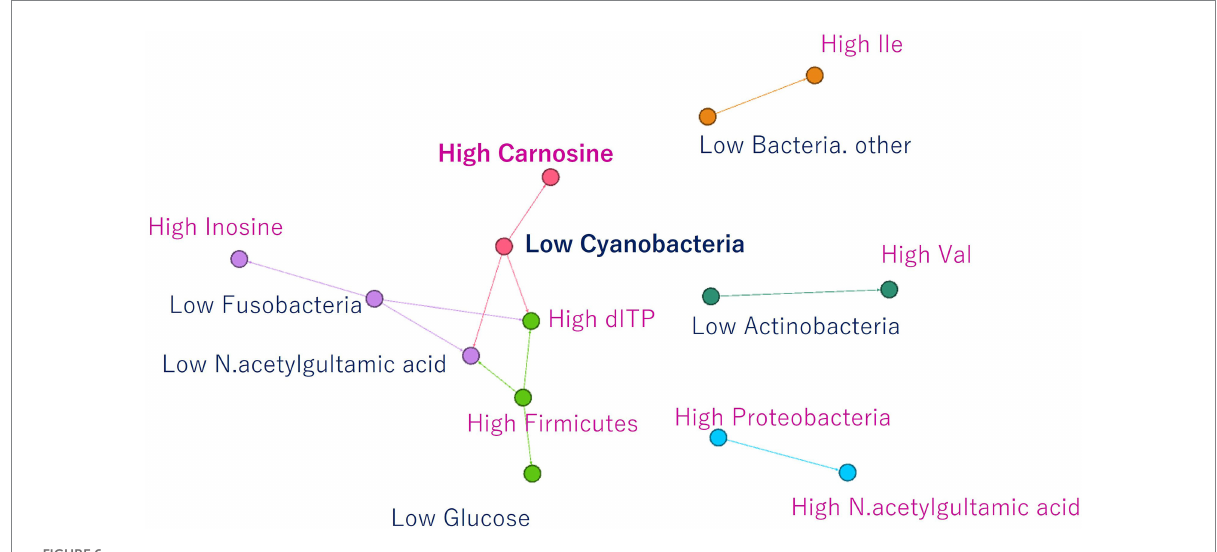
FIGURE 6 Association rules for NMR signals that increase or decrease due to an increase or decrease in microbes. Three isolated relationships and relationships between three microbes and five metabolites were